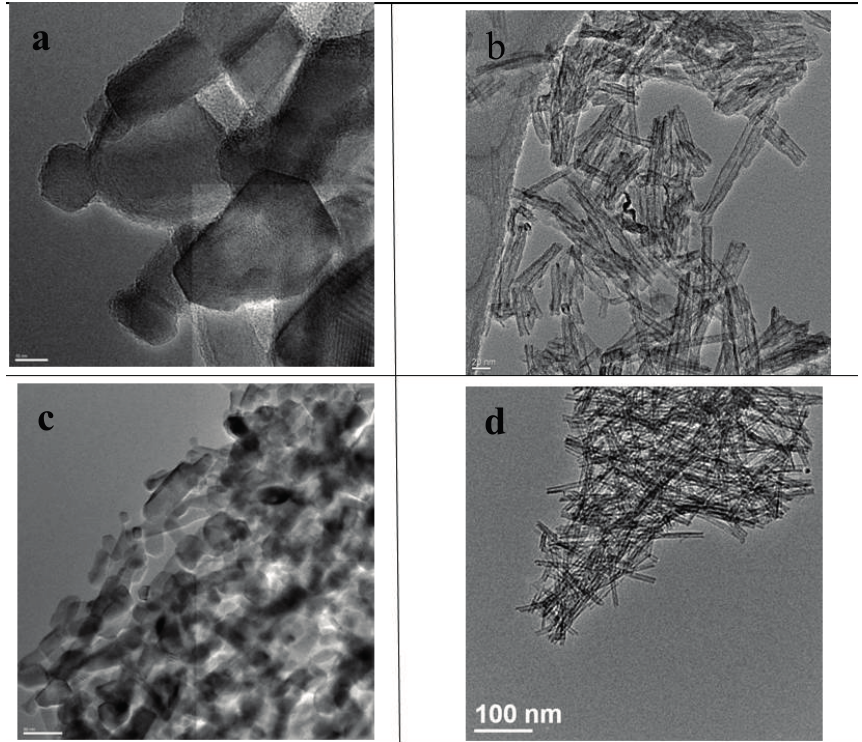
Figure 3. TEM images of the TiNT-O 2 and the cTi-NT-O 2 : ( a ) cTiNT-O 2 with a magnification scale of 20 nm; ( b ) TiNT-O 2 with a magnification scale of 20 nm; ( c ) cTiNT-O 2 with a magnification scale of 50 nm; ( d ) TiNT-O 2 with a magnification scale of 100